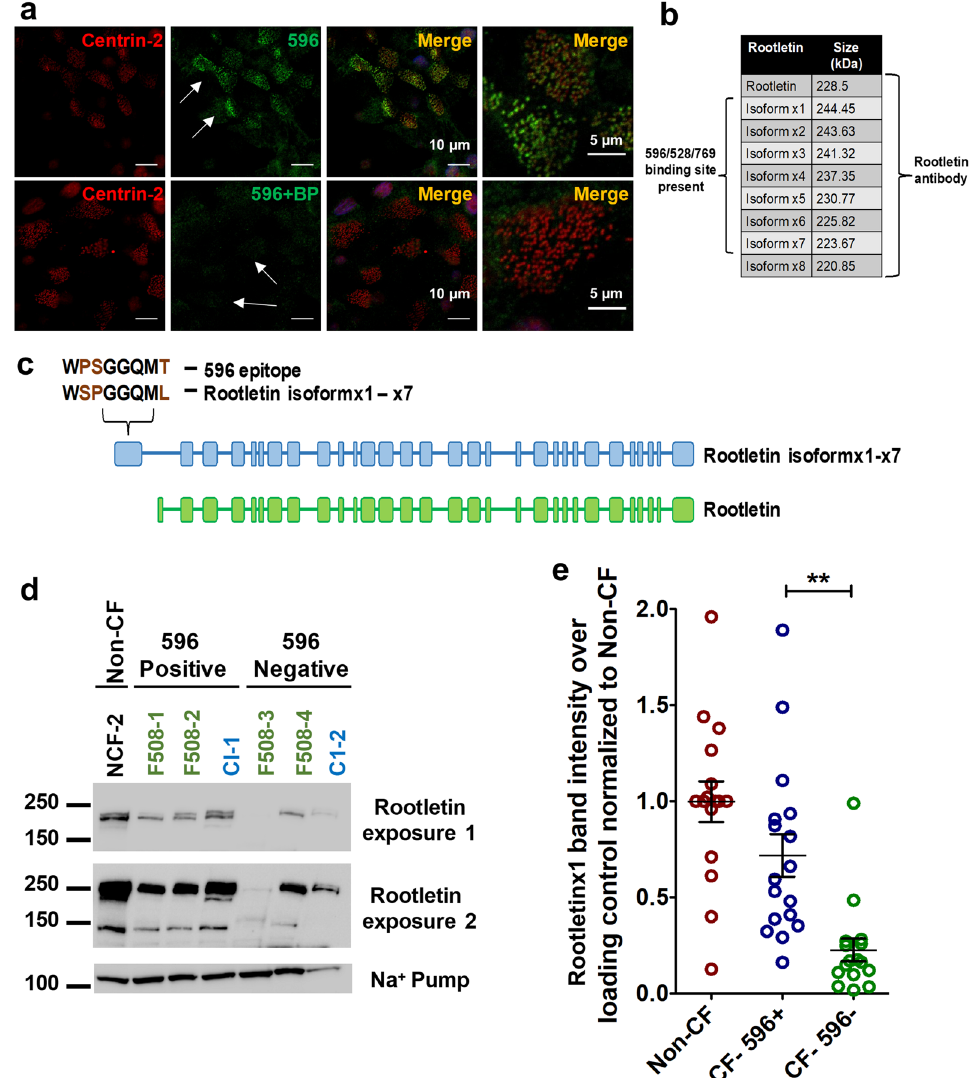
Figure 6. Blocking peptide WPSGGQMT abolishes 596 immunostaining at the bases of cilia. ( a ) Well differentiated HBEs were co-immunostained using 596 and centrin-2 antibodies without (top row) or with (bottom row) a blocking peptide corresponding to the 596 epitope . White arrows indicate ciliated cells. Zoomed-in images are shown at extreme right. ( b ) Rootletin isoforms containing a sequence homologous to the 596 epitope in CFTR. ( c ) Cartoon showing location of the pseudo-epitope in rootletin isoforms. ( d ) Immunoblot of well differentiated HBE cell lysates from a non-CF donor and six CF patients probed using rootletin antibody. Green and blue labels indicate donor is homozygous for F508del and a Class I mutation, respectively. Short (1) and long (2) exposures are shown. After short exposure note that rootletin was only detected in 596+ cell lysates. ( e ) Summary of rootletinX1 protein expression. Each point is the lysate from a different culture prepared from five non-CF donors, five 596+ donors and three 596- donors. Note that rootletinX1 band intensity is significantly lower in cells that are not immunostained using CFTR antibody 596 (mean ± SE, n = 16–17, ** p = 0.0018, one-way